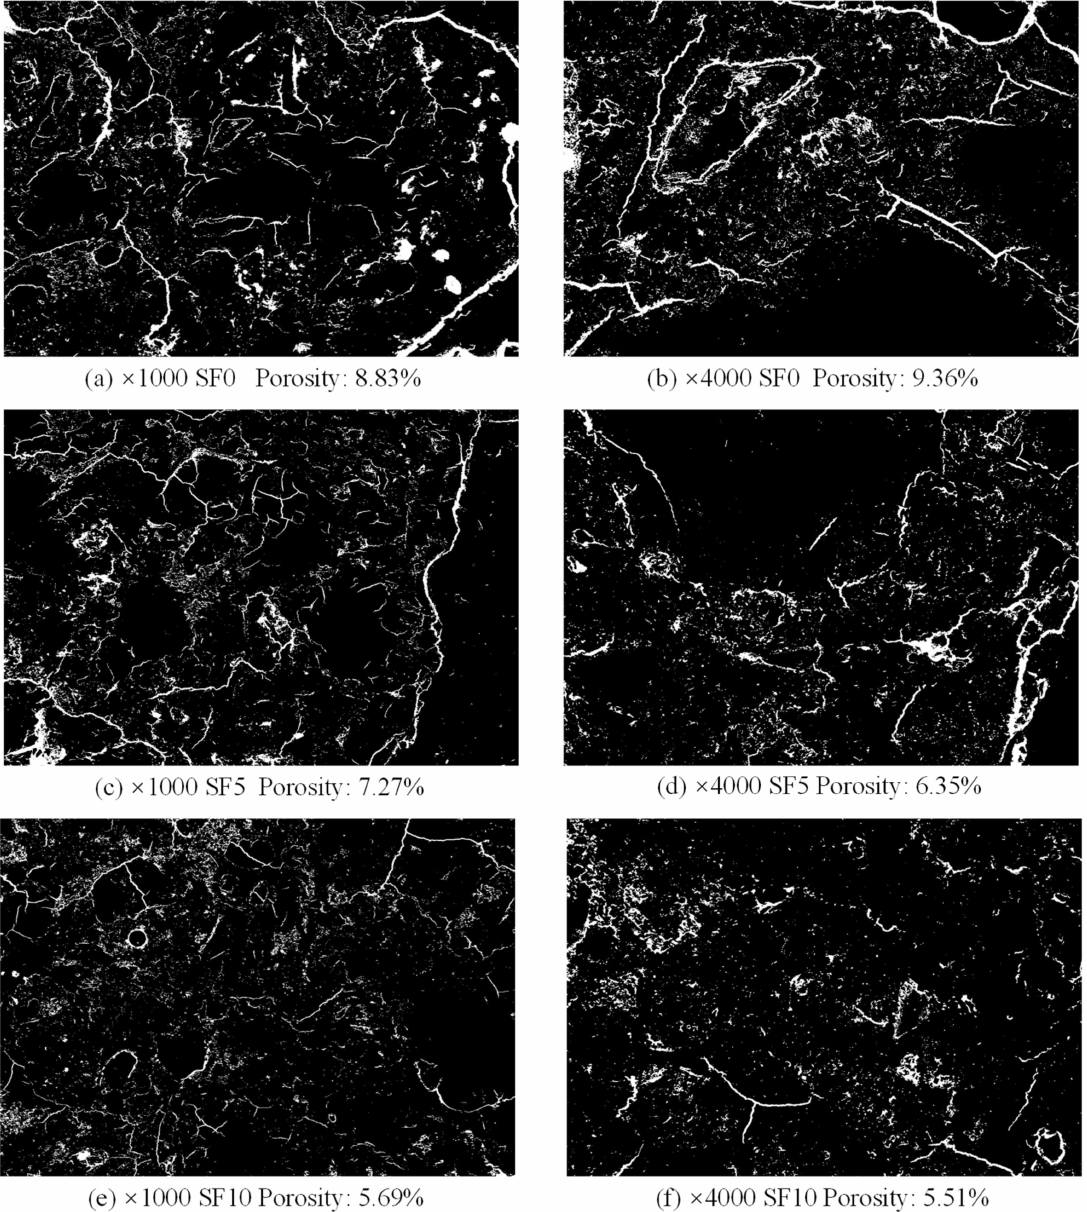
Figure 4. Binary images after processing of mortar samples. ( a ) sample SF0 with 1000 times magnifi- cation; ( b ) sample SF0 with 4000 times magnification; ( c ) sample SF5 with 1000 times magnification; ( d ) sample SF5 with 4000 times magnification; ( e ) sample SF10 with 1000 times magnification; ( f ) sample SF10 with 4000 times